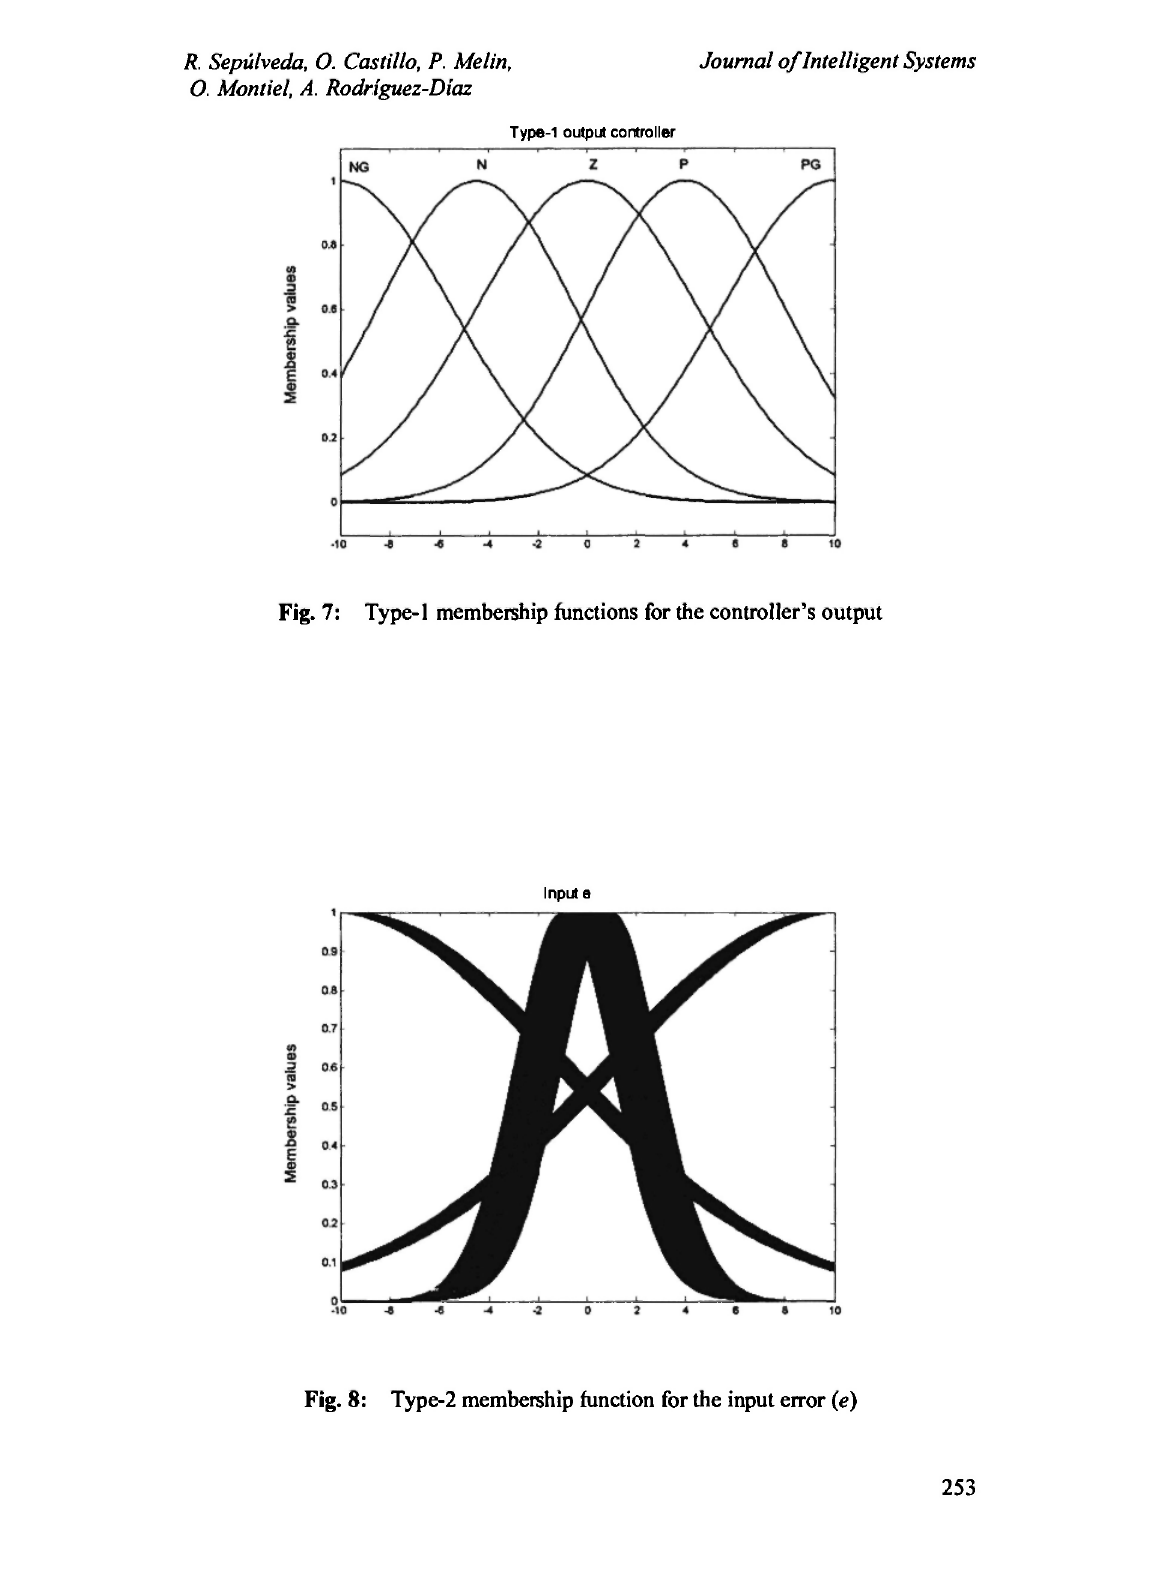
Fig. 8: Type-2 membership function for the input error (e)